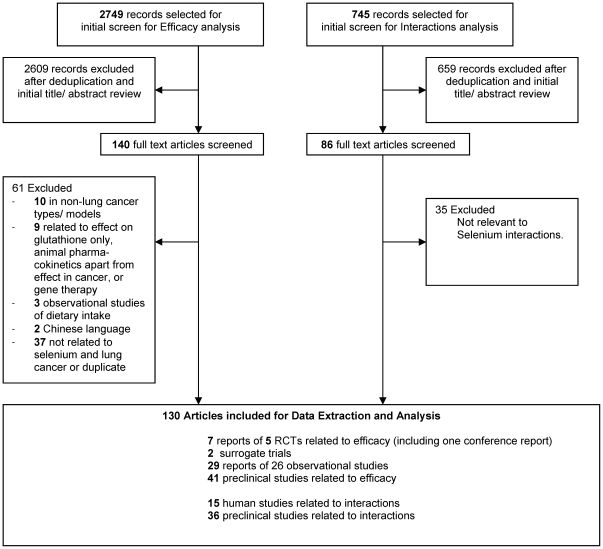
Literature Flowchart.